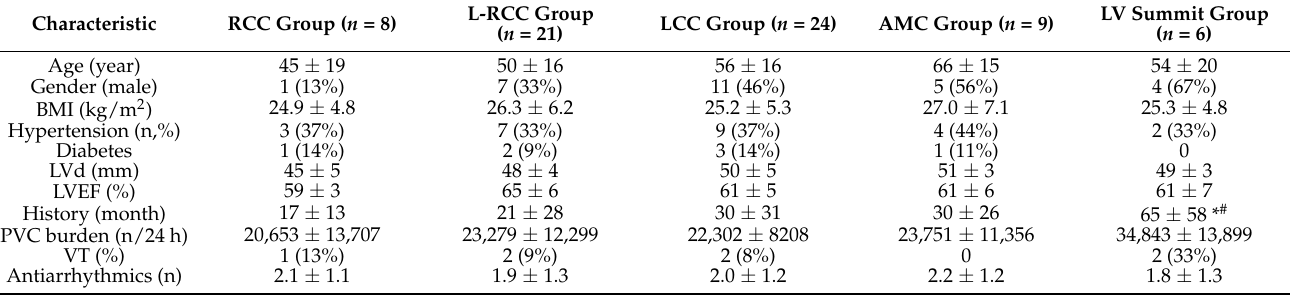
Table 1. Patients and clinical